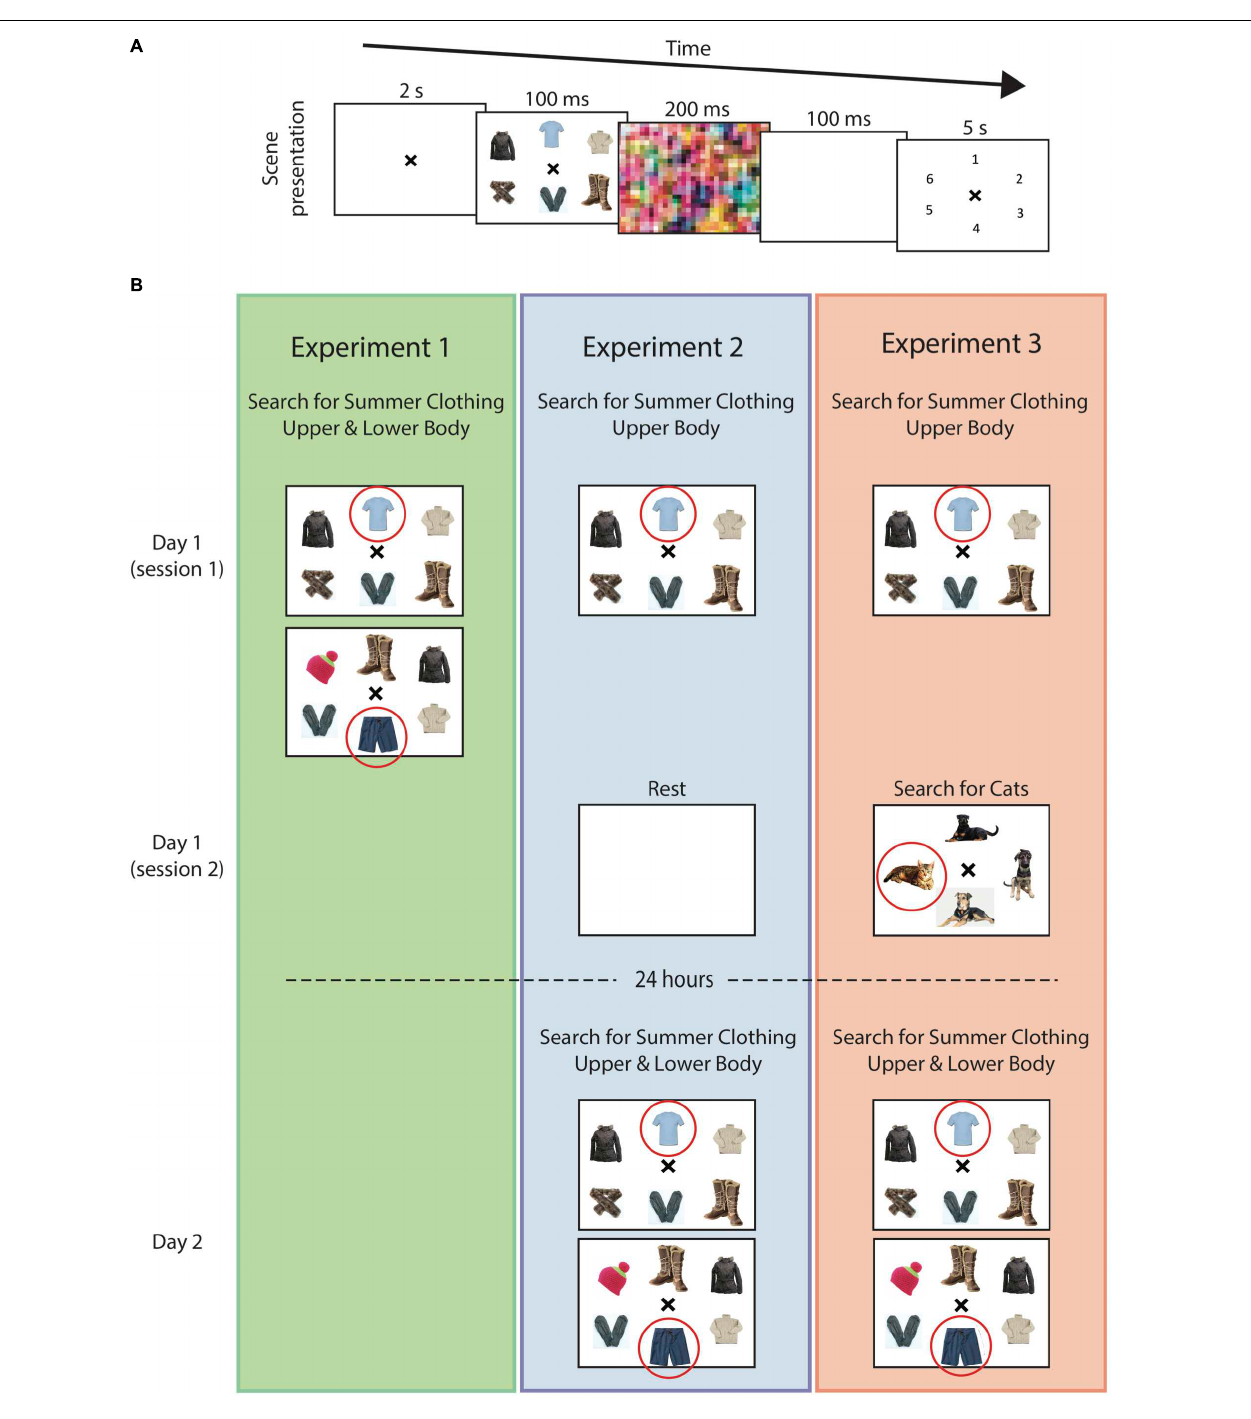
FIGURE 1 | Visual search task. (A) In all experiments, subjects were shown an array of winter clothing items (distractors) with, in most cases, a single summer clothing item (target). Each array was followed by a visual screen. Subjects were then asked to select the location corresponding to the target search item. (B) In Experiment 1 ( left ), subjects searched for both upper-body and lower-body clothing items in randomly interspersed trials. In Experiment 2 ( center ), participants searched for upper-body clothing items on Day 1 and following 24 h, searched for upper-body and lower-body clothing items in randomly interspersed trials, similar to the paradigm used in Experiment 1. In Experiment 3 ( right ), participants searched for upper-body items on Day 1, similar to Experiment 2. Immediately following this experiment, subjects then performed an unrelated visual search task (cats vs. dogs). The following day, similar to Experiment 2, participants searched for both upper-body and lower-body clothing items in randomly interspersed trials. The circled item represents the target search summer clothing article (these were not shown during the task). Images were selected via with search engine provided at https://search.creativecommons.org.